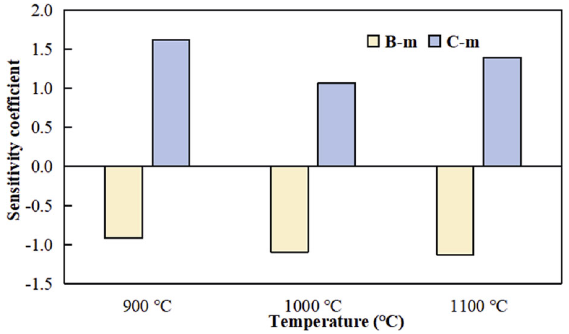
Fig. 12 Analysis of the sensitivity coefficient of the main intermediate gas species containing boron (B-m) and containing carbon (C-m) at different